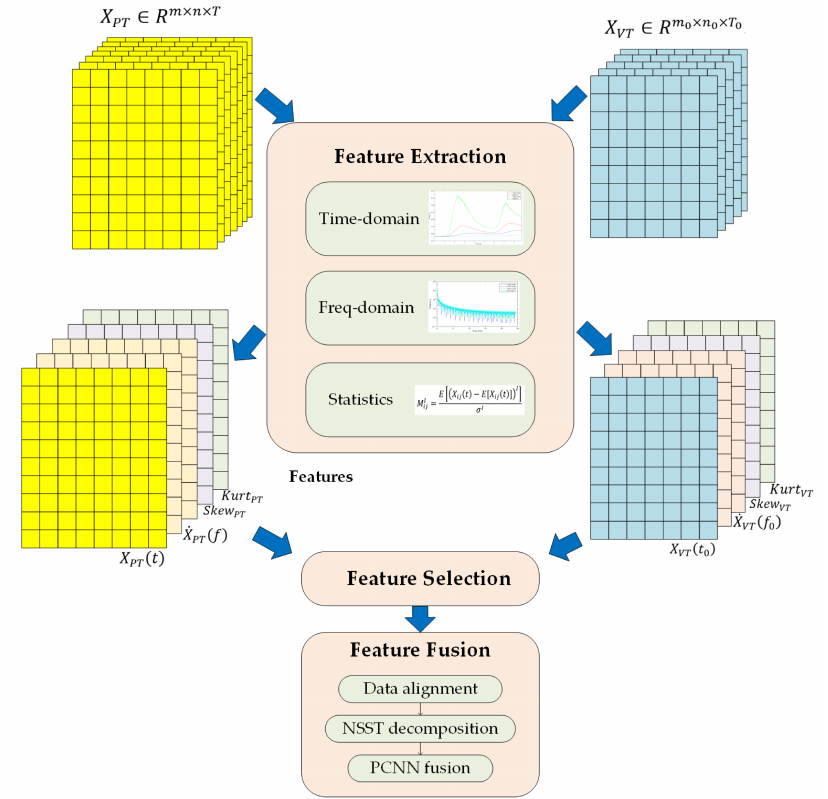
Figure 7. An example demonstration of three-step integration framework: feature extraction, selection and fusion